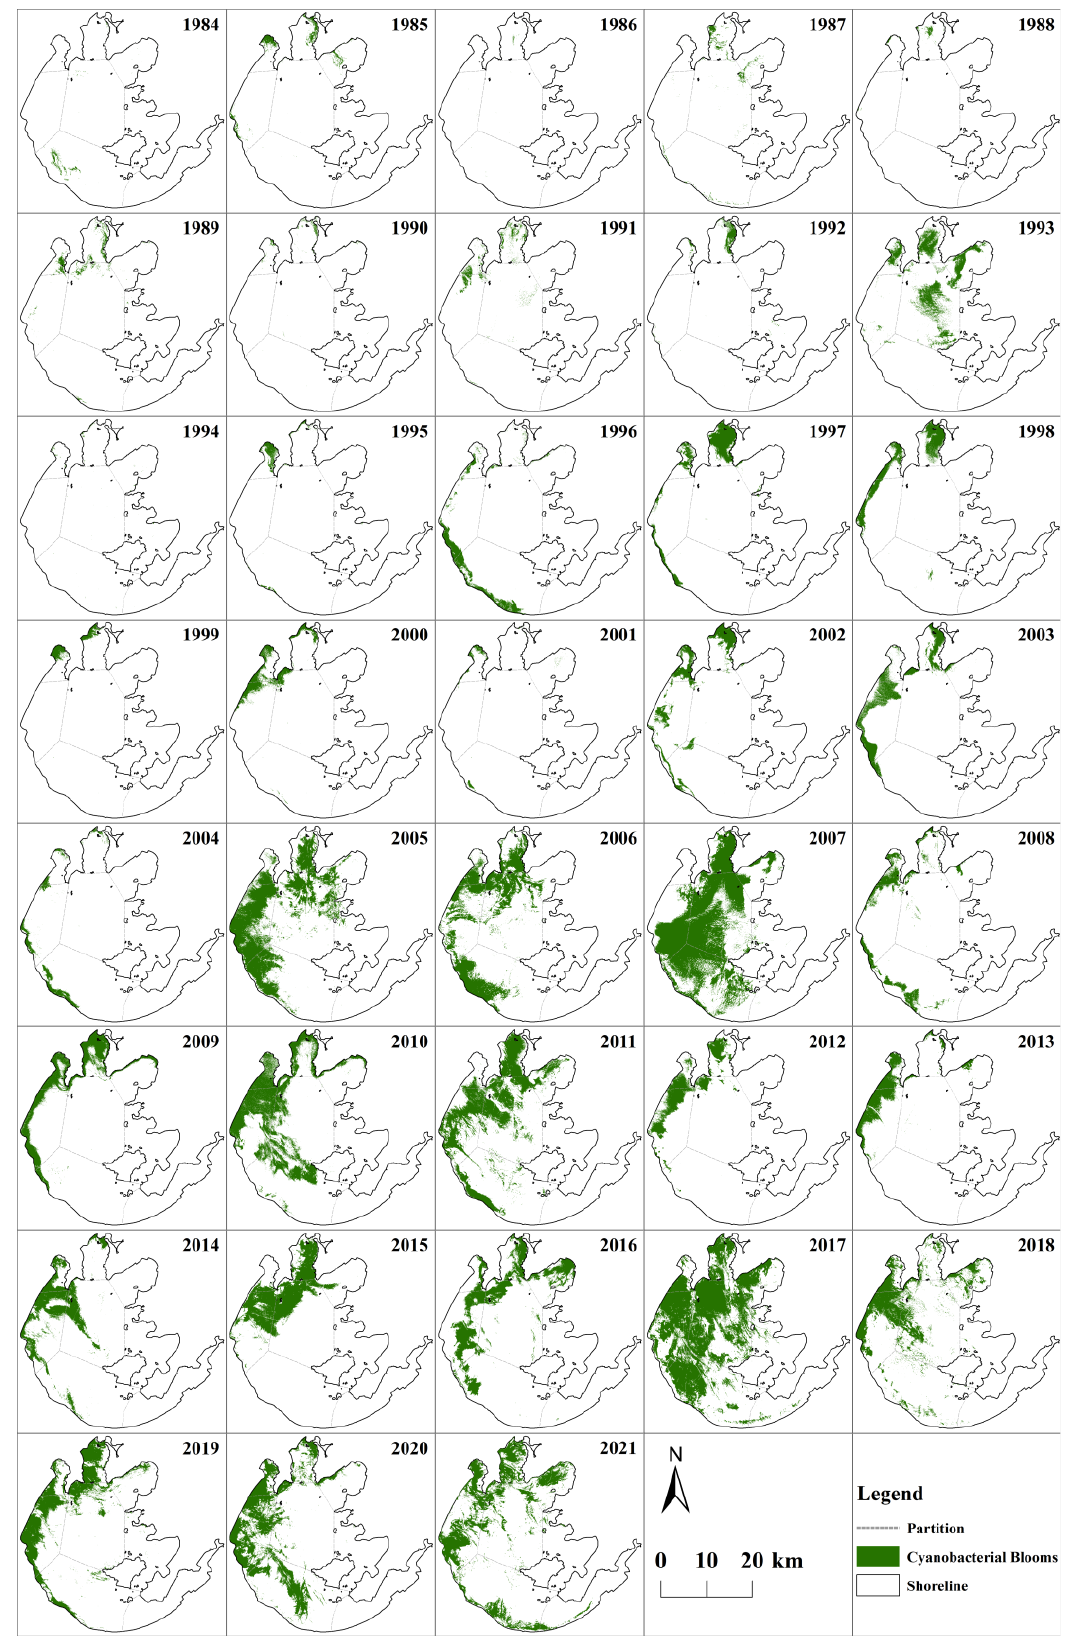
Figure 6. Spatial distribution of annual cyanobacterial blooms for the entire lake and each segment. As shown in Figure 7, the CAP for cyanobacterial blooms across the lake has in- creased consistently over the last 40 years (from 0.05% to 38.28%, p < 0.05). From 1984 to 2004, the CAP changes were more stable, fluctuating from 0.05% to 7.89%. From 2005 to